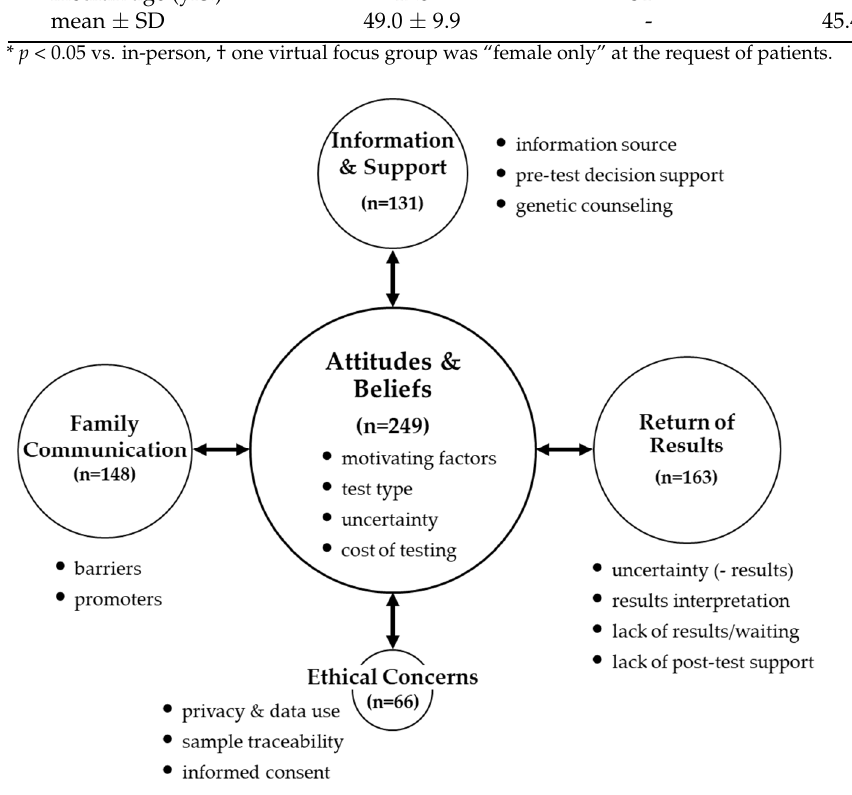
Figure 1. Themes and sub-themes of focus group discussions. The schematic depicts the major themes (circles) and sub-themes (bullets) across the six focus groups ( n = 58). Circle size reflects the frequency of times the theme was noted in all groups. Pre-test experiences include the themes ‘information & support’ and ‘attitudes & beliefs.’ Post-test experiences include the themes ‘return of results’ and ‘family communication.’ The theme ‘ethical concerns’ (related to both pre- and post-test experiences) was the least frequently cited theme.